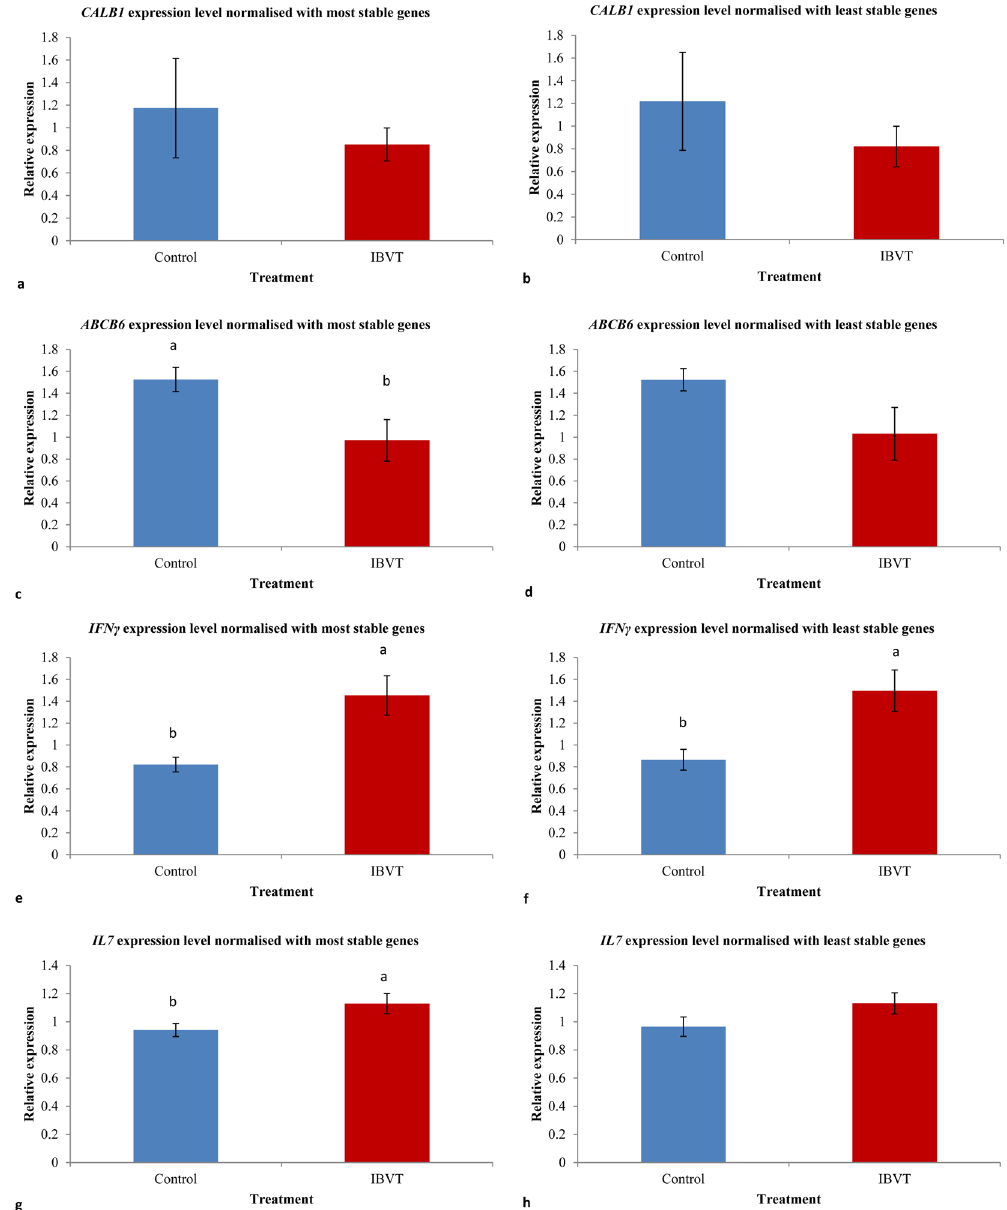
Figure 4. Relative expression levels of the candidate target genes affected by IBV T challenge in the shell gland and spleen of laying hens. ( a ) CALB1 expression level in the shell gland normalized with the most stable genes YWHAZ and TBP (P = 0.6783). ( b ) CALB1 expression level in the shell gland normalized with the least stable genes SDHA and ALB (P = 0.7788). ( c ) ABCB6 expression level in the shell gland normalized with the most stable genes YWHAZ and TBP (P = 0.0152). ( d ) ABCB6 expression level in the shell gland normalized with the least stable genes SDHA and ALB (P = 0.0713). ( e ) IFN γ expression level in the spleen normalized with the most stable genes YWHAZ and TBP (P = 0.0021). ( f ) IFN γ expression level in the spleen normalized with the least stable genes RPL4 and ALB (P = 0.0050). ( g ) IL7 expression level in the spleen normalized with the most stable genes YWHAZ and TBP (P = 0.0333). ( h ) IL7 expression level in the spleen normalized with the least stable genes RPL4 and ALB (P = 0.1130). Values are relative expression quantities and error bars show standard error. Across the treatment, a,b show significant difference (p < 0.05). For the candidate target genes, normalised relative quantities (NRQ) were calculated in qbase + based on ( −ΔΔ 2 Cq ) approach with a genes specific amplification efficiencies to show the relative expression of Cq levels in folds to the mean Cq of all samples of the genes. NRQ values were further analysed in Statview software (SAS) and Tukey-Kramer test was used to differentiate level of significance (p < 0.05) between means. A total of 20 samples for each of the groups (IBV T and control) in each tissue (shell gland or spleen) were processed for qPCR